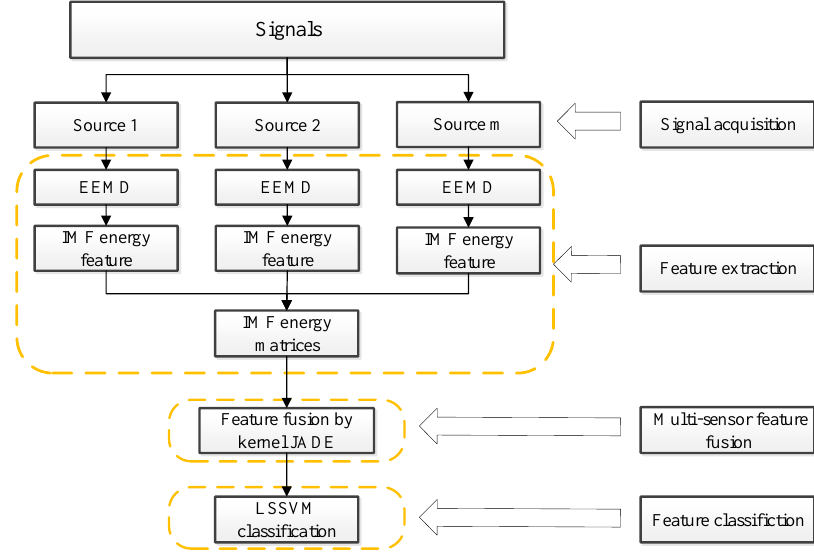
Figure 1. Method framework.